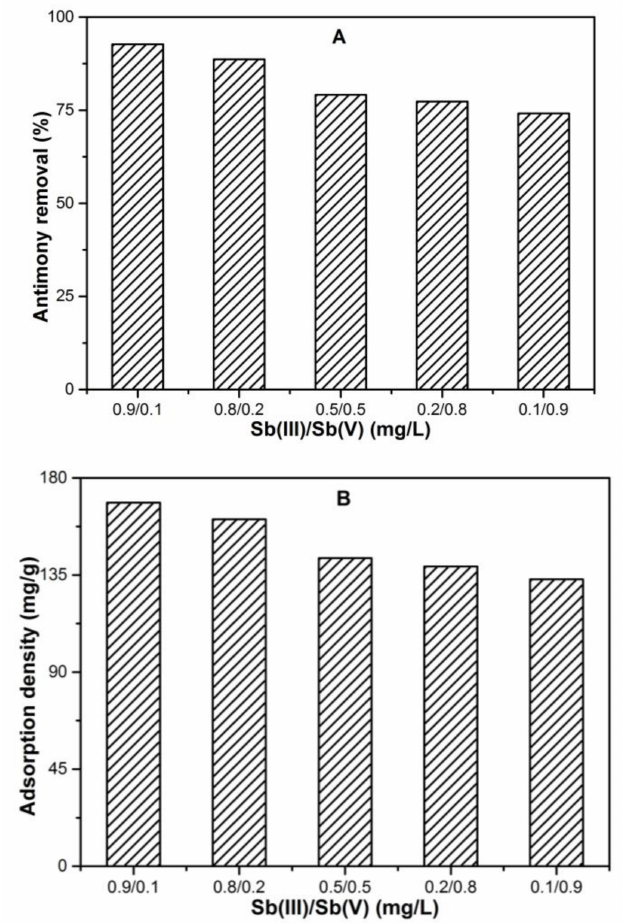
Figure 4. Overview of removal response for coexisting Sb(III) and Sb(V) species under neutral pH, 0.1 mM FC dose, 1 mg/L initial Sb concentration and temperature T 25 ◦ C; ( A ) antimony removal (%); ( B ) adsorption densities